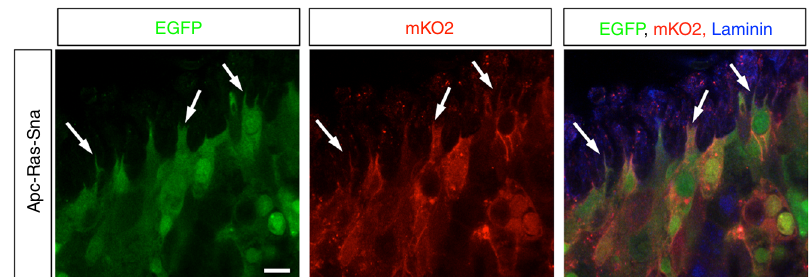
Fig. 4 Groups of cells in the midgut expressing Apc-Ras-Sna are highly protrusive at their edges. Apc-Ras-Sna tumors labeled with the dBrainbow reporter. Fixed midguts were stained for green fl uorescent protein (visualizes enhanced GFP, green), red fl uorescent protein (visualizes mKO2, red), and Laminin (blue). Scale bar = 10 µ